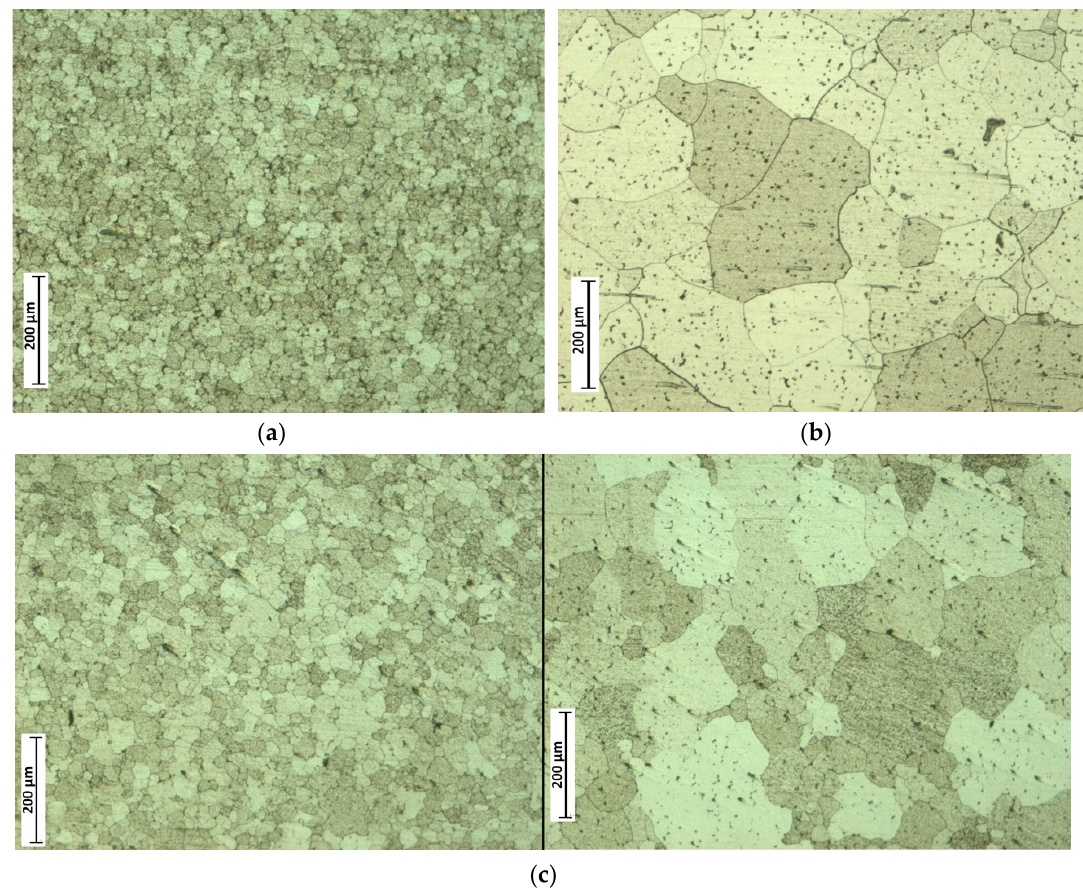
Figure 5. Microstructures after chemical etching of molybdenum powder (Mo-45) sintered under 90 MPa pressure without holding time at: ( a ) 1750, ( b ) 2000 and ( c ) 1900 °C (left: edge, right: core).